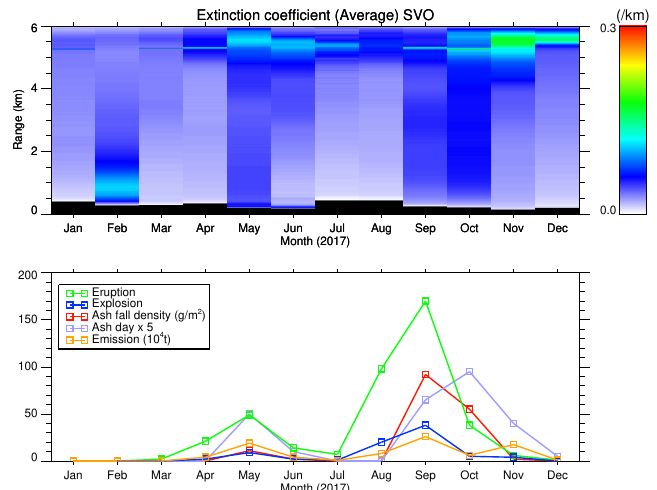
Figure 3. Time-range plot of monthly averaged aerosol extinction coefficients at 532 nm detected by the SVO lidar in 2017 ( top ); and the monthly numbers of eruptions and explosions at Sakurajima, the density of ash fall on the ground, the number of confirmed ash fall days at the Kagoshima observatory, and the estimated mass of ash erupted ( bottom ). The number of confirmed ash fall days is rescaled by a factor of 5 to facilitate